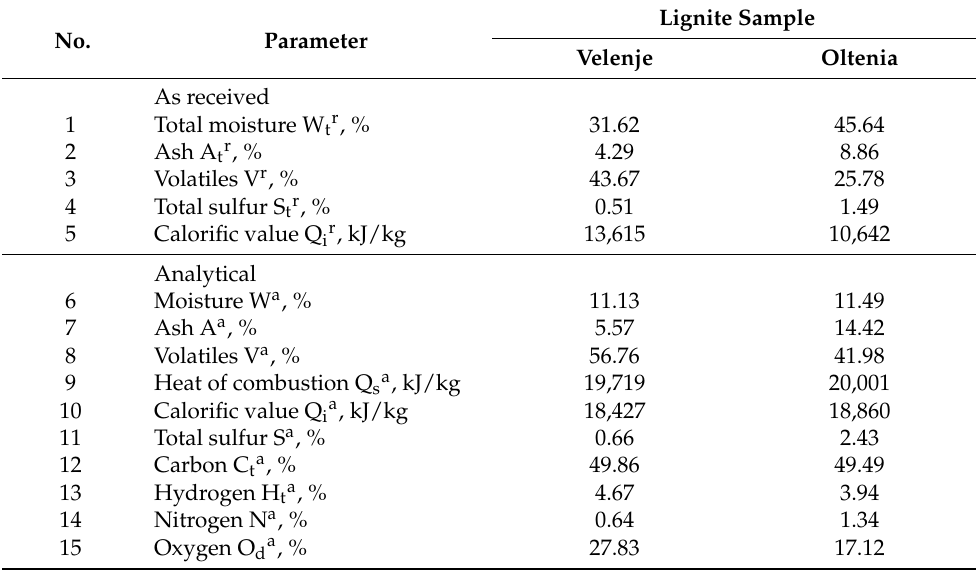
Table 1. Physicochemical characteristics of lignites used for the ICG tests.